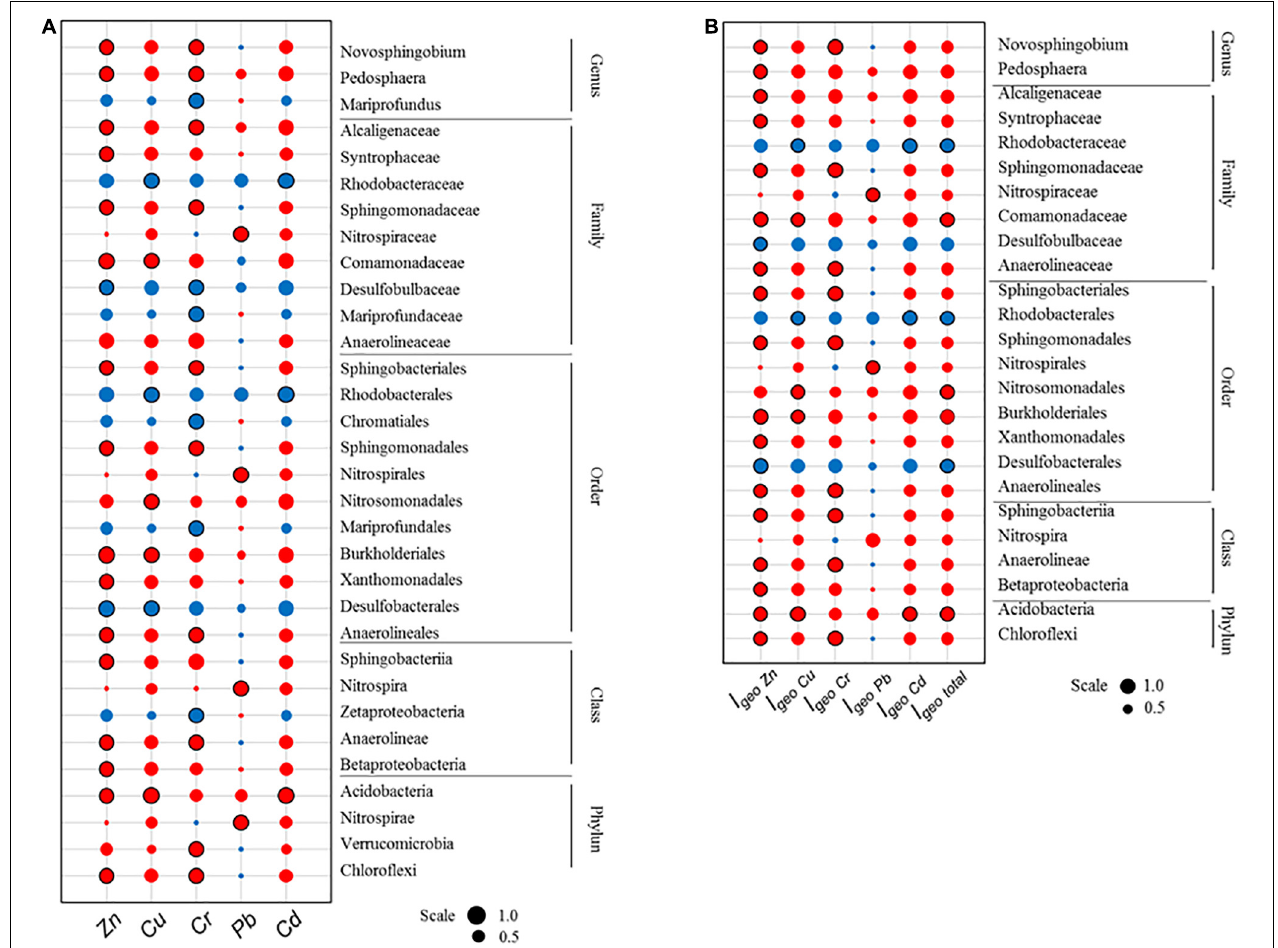
FIGURE 7 | Spearman’s correlation between (A) heavy metal concentration or (B) heavy metal I geo index and relative abundances of dominant bacterial taxa in microbial communities from sediment samples collected in October 2015. Red and blue colors indicate positive and negative correlations, respectively. Scale represents the numeric data of Spearman coefficients. Significant correlations ( P < 0.05) are indicated by a black circular